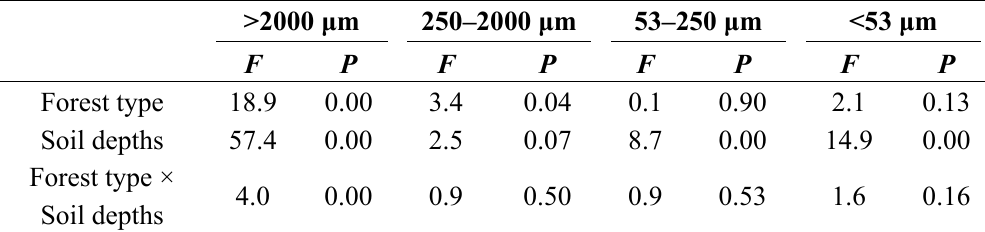
Table 3. Significance of the effects of forest type, soil depths, and forest type × soil depths on the proportion of water-stable aggregates in the two-way analysis of variance (ANOVA).